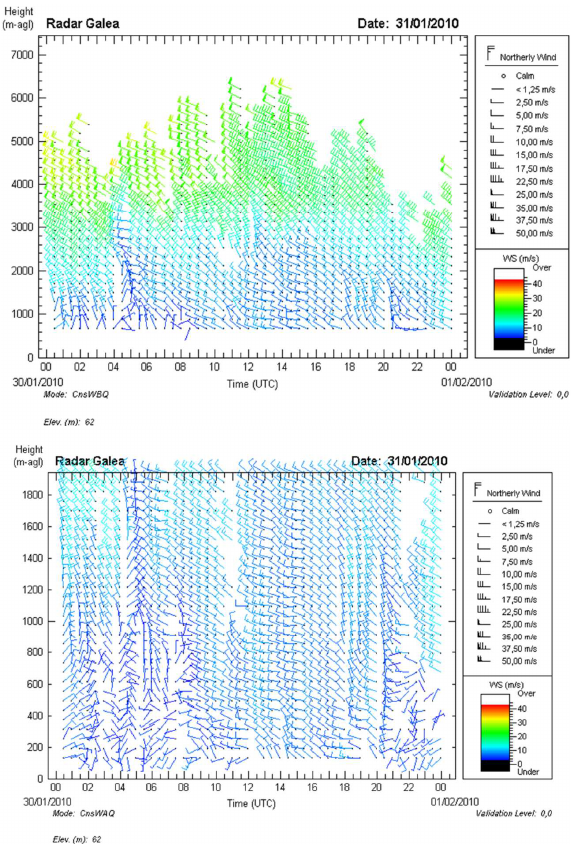
3 Fig. 14. Stratiform precipitation pattern: meteorological observations plot from the wind profiler 4 (WPR) on 31 January 2010. Top panel, Barb plot for high mode observation with resolution of 5 Fig. 14. Stratiform precipitation pattern: meteorological observa- 200m. Bottom panel, Low mode observation with higher resolution of 60m. X axis (Time UTC). 6 Y axis (Height in meters above ground level). 7 tions plot from the wind profiler (WPR) on 31 January 2010. (top) Barb plot for high mode observation with resolution of 200m. (bot- tom) Low mode observation with higher resolution of 60m. x axis (time UTC). y axis (height in ma.g.l.).